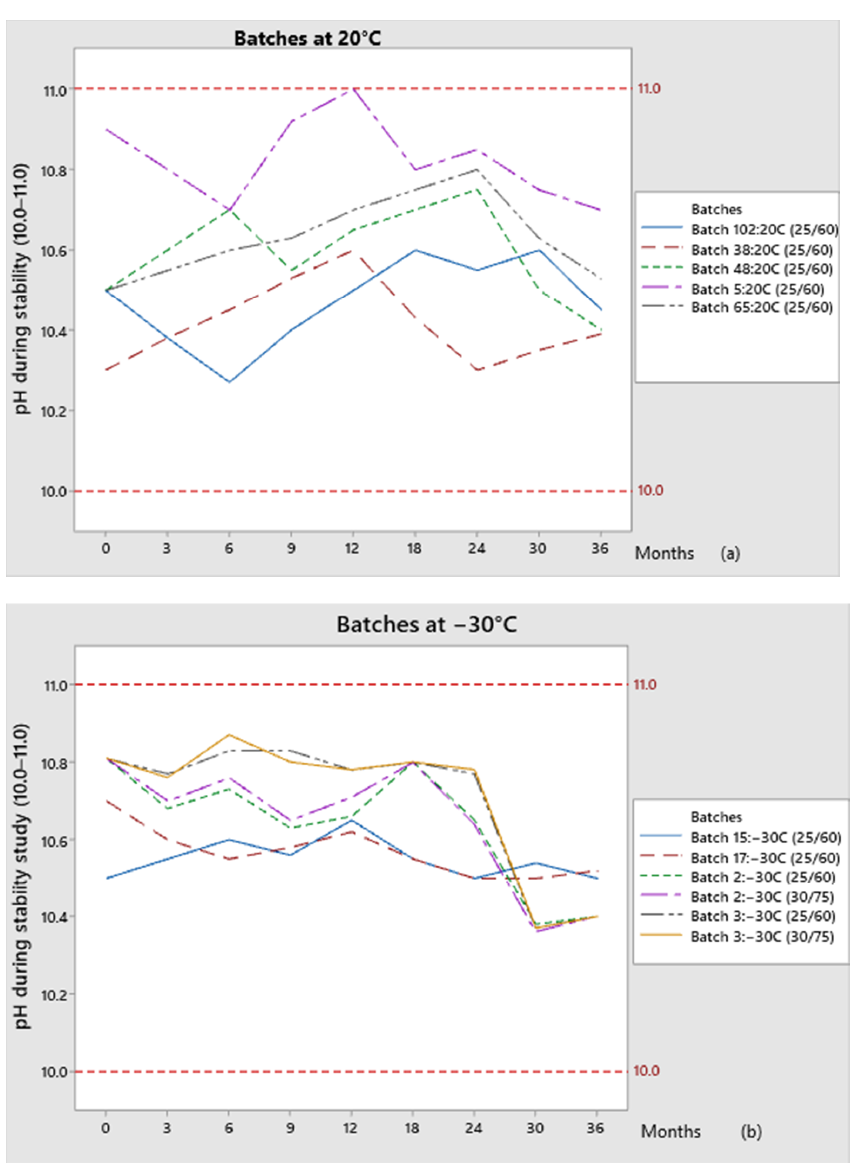
Figure 5. Comparison of pH values during the stability study for the batches: ( a ) Kept at 20 ◦ C; ( b ) Kept at − 30 ◦